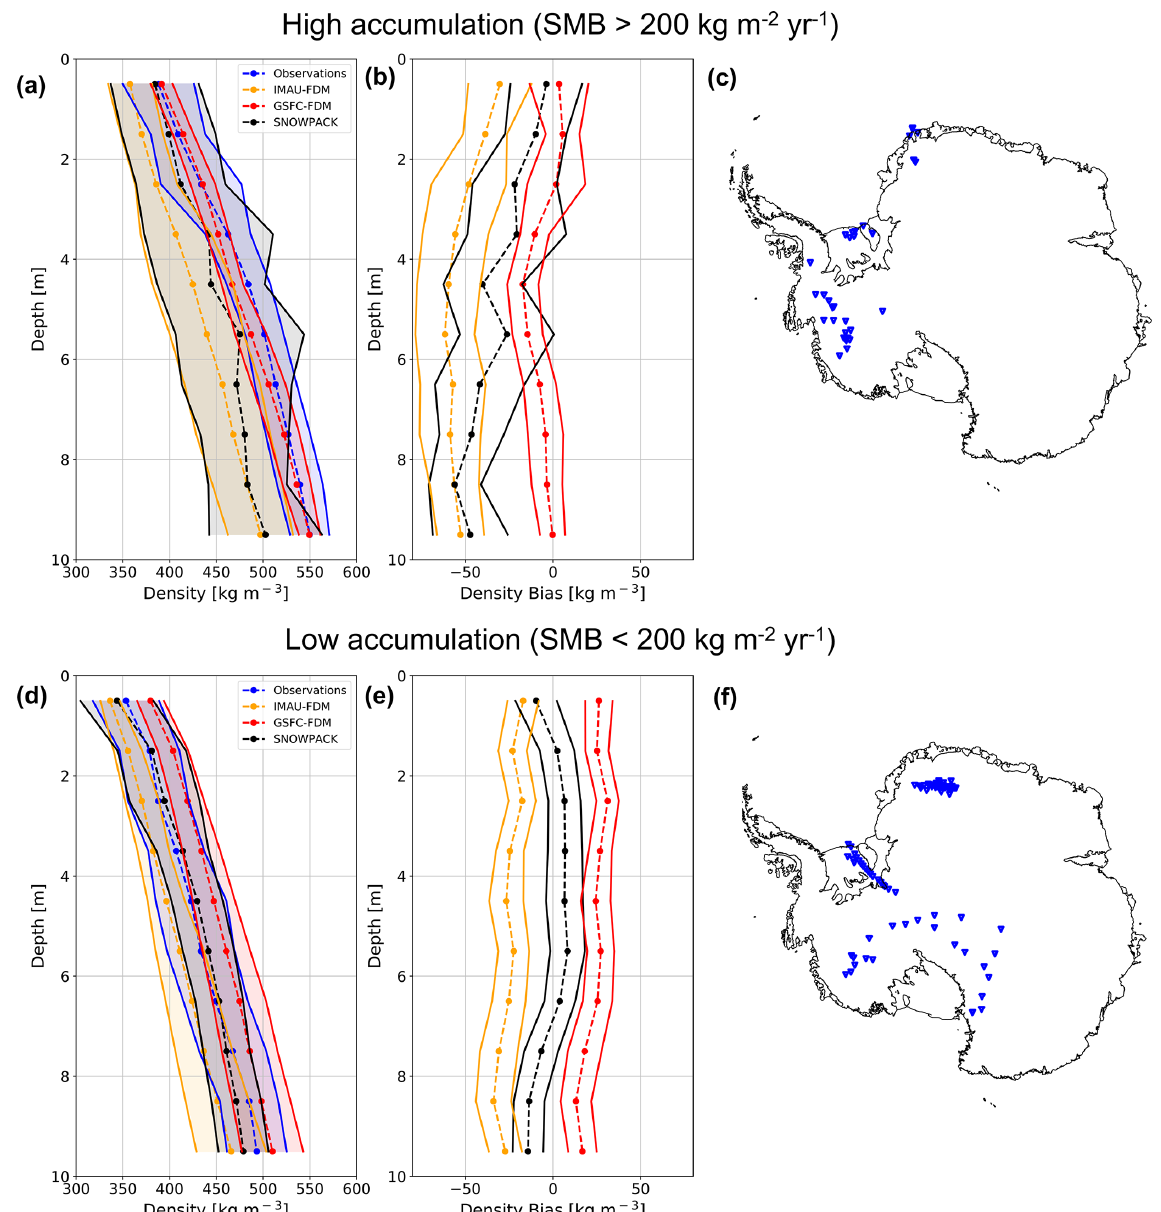
Figure 9. High- and low-SMB density profile comparison. Average observed (blue dashed), SNOWPACK-modeled (black dashed), GSFC- FDM-modeled (red dashed), and IMAU-FDM-modeled (yellow dashed) near-surface (0–10m) density profiles at high-SMB (a) and low- SMB (d) sites. Shading represents plus and minus 1 standard deviation across observed and modeled density profiles. Mean SNOWPACK minus observed (black dashed), GSFC-FDM minus observed (red dashed), and IMAU-FDM minus observed (yellow dashed) density profiles at high-SMB (b) and low-SMB (e) sites. Error bars represent 95% confidence intervals on bias means. Maps of locations of high-SMB (c) and low-SMB (f) sites. High- and low-SMB sites are delineated by a 200kgm − 2 yr − 1 threshold applied to MERRA-2 1980–2017 mean annual